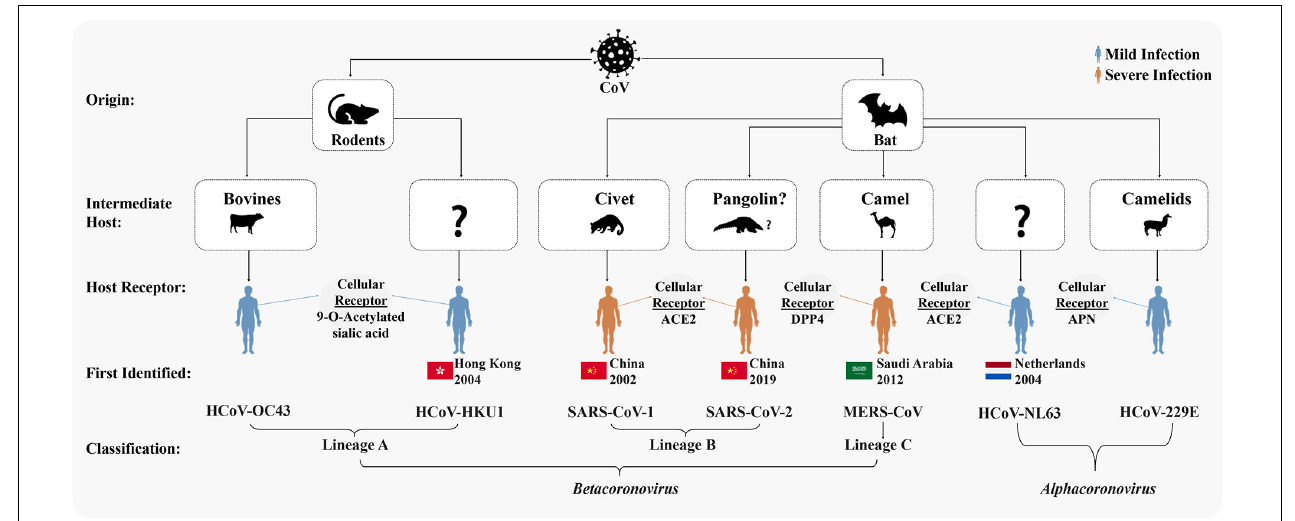
FIGURE 1 | Origins and taxonomy of human coronaviruses (HCoVs). Severe acute respiratory syndrome coronavirus (SARS-CoV-1) and Middle East respiratory syndrome coronavirus (MERS-CoV) were transmitted to humans from bats by civet cats and dromedary camels, respectively. The severe acute respiratory syndrome coronavirus-2 (SARS-CoV-2) was likely transmitted to human from bats via an intermediate host pangolin (Andersen et al., 2020; Sun et al., 2020; Wu F. et al., 2020; Zhang T. et al., 2020; Zhou P. et al., 2020). Cellular receptors of all the seven HCoVs are mentioned. Among the seven HCoVs, HCoV-229E and HCoV-NL63 belong to Alphacoronavirus ; HCoV-OC43 and HCoV-HKU1 belong to lineage A, SARS-CoV-1 and SARS-CoV-2 to lineage B, and MERS-CoV to lineage C of Betacoronavirus .